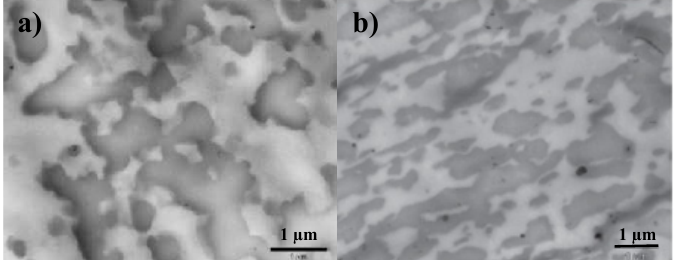
Figure 1. Examples of thermoplastic vulcanizate (TPV) morphology (crosslinked by Resol) from Transmission Electronic Microscopy (TEM) ( a ) PP/EPDM: (30/70) [2] ( b ) PP/EPDM (50/50) [8] with permission from Elsevier.